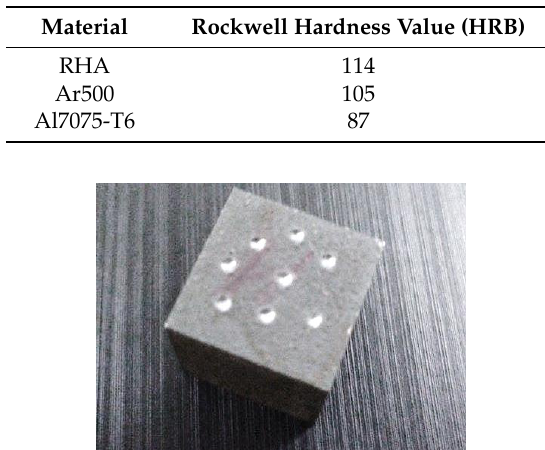
Figure 8 . After hardness test condition with different punching points.